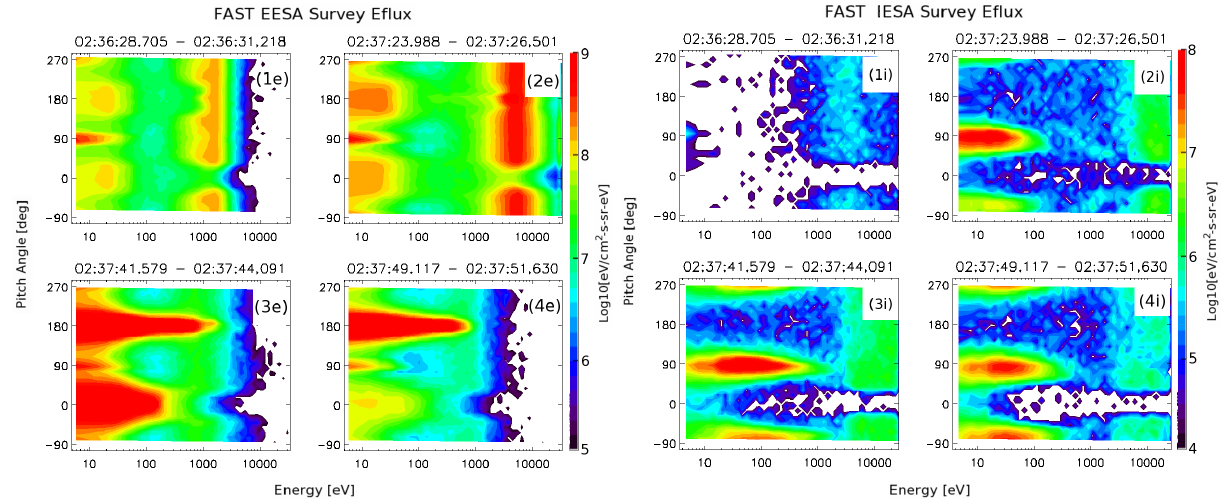
Fig. 6. Selection of FAST electron (left) and ion (right) distribution functions, in energy – pitch-angle coordinates. The respective times are indicated by arrows in Fig. 5, and were chosen as follows: at the middle of the less energetic electron precipitation interval (1), at the maximum electron energy flux (2), at the maximum electron upward (3) and downward (4) number